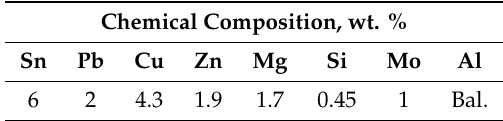
Table 1. Chemical composition of studied alloy.